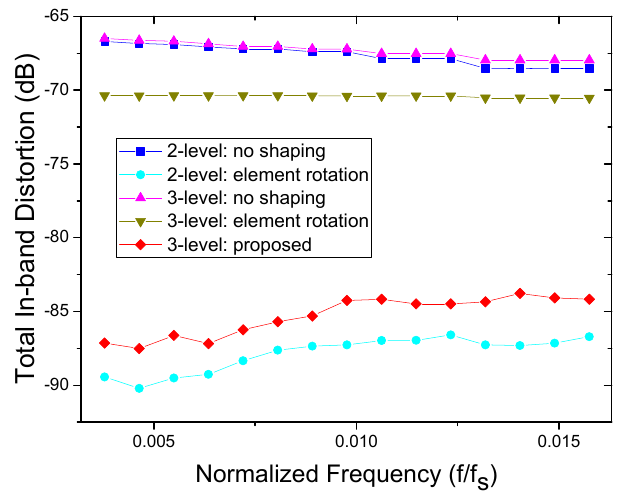
Figure 9. Total in-band distortion ( N fft = 8192, M = 2 4 , OSR = 10, σ C = 1%).